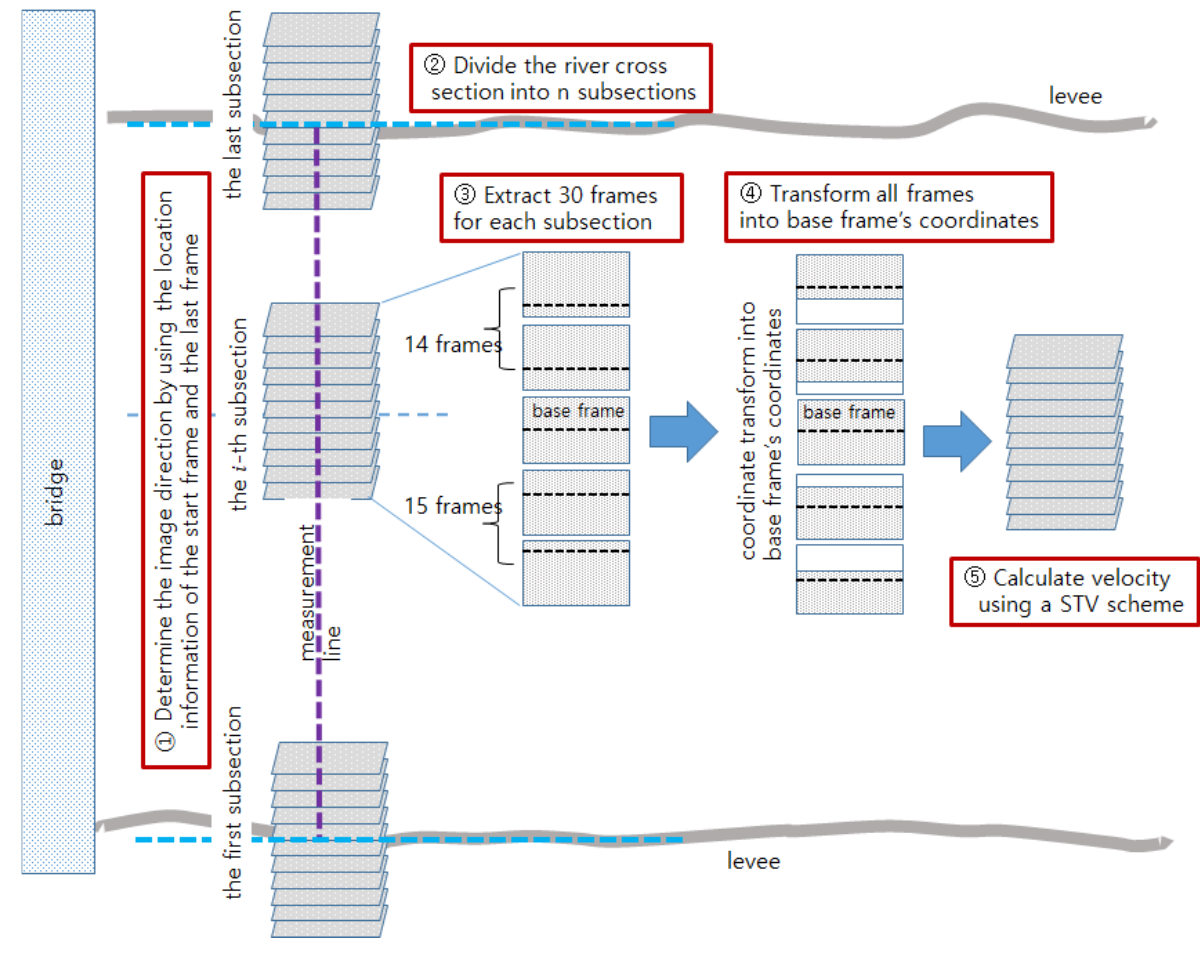
Figure 3. Schematic of the navigating drone method.